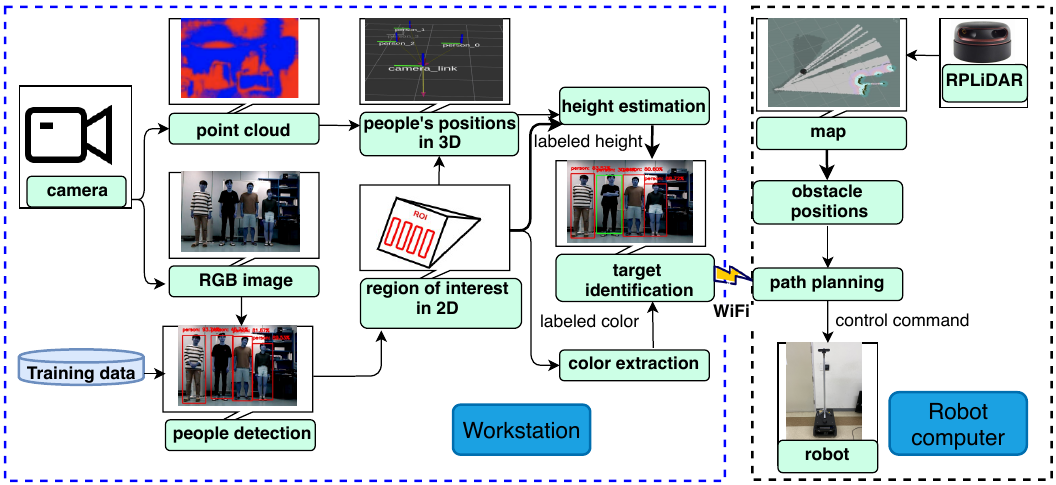
Figure 2. Framework of identification